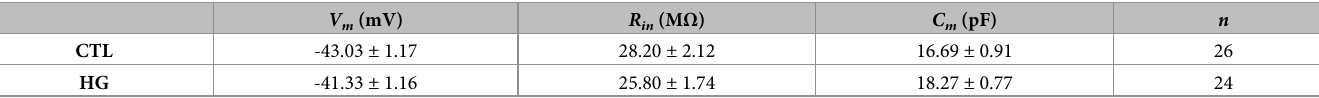
Table summarizes the membrane potential ( V WT mice maintained in either control or high glucose conditions. Means were compared by unpaired t -test, no significant differences were found between the